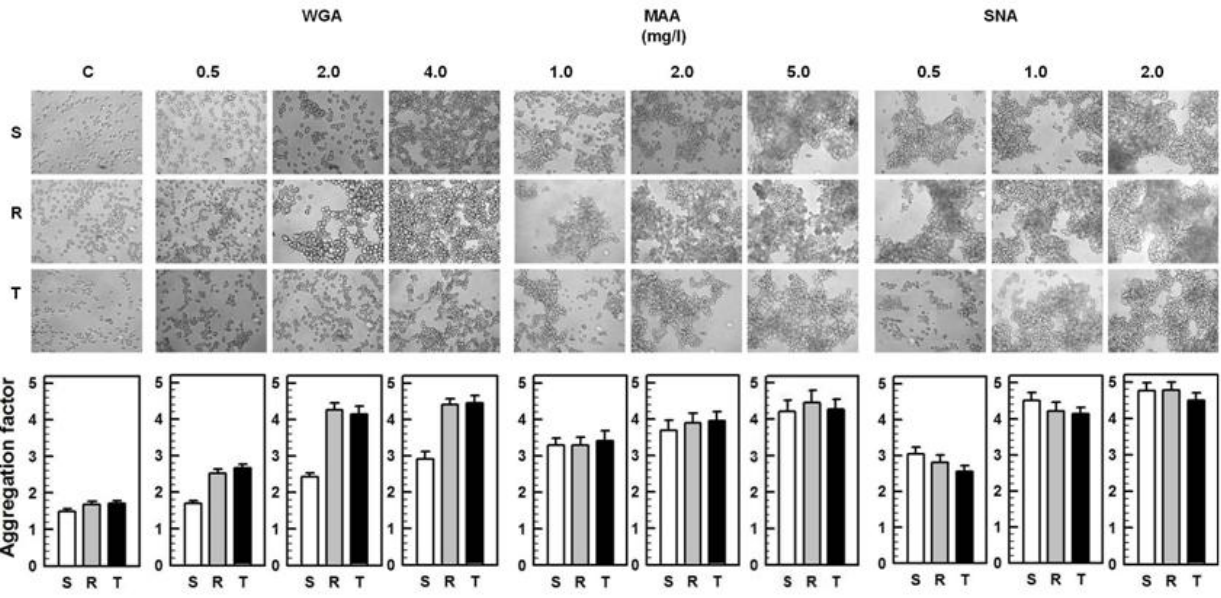
Figure 2. Monitoring of S, R and T cell agglutination by WGA, MAA and SNA. After incubation with lectins (see materials and methods), cells were studied by light microscopy and counted using the CASY Model TT Cell Counter. Microscopic images are representative of three independent experiments. Data are presented as the mean ± SD of three independent